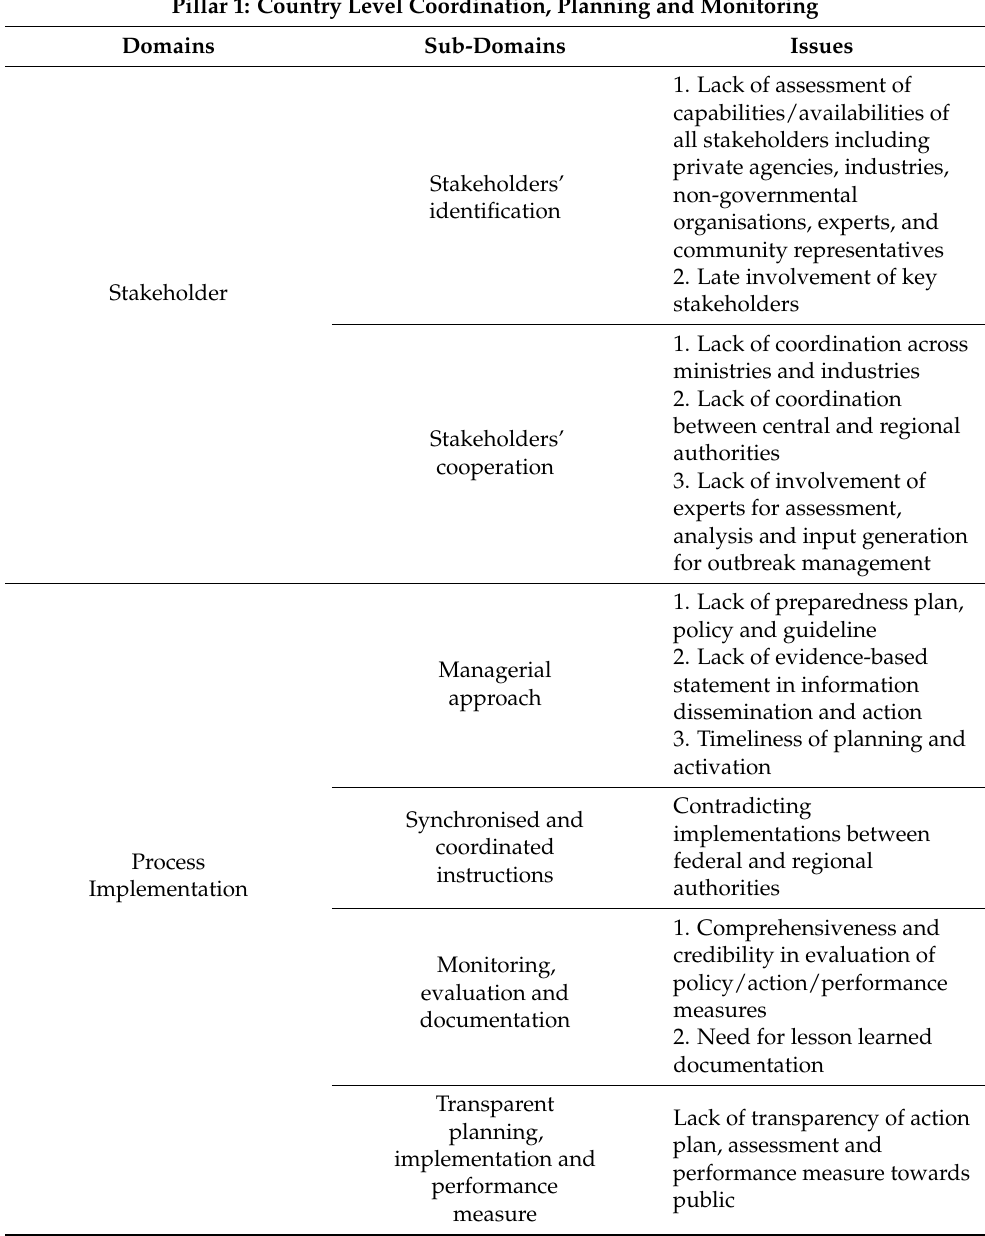
Table 2. Perception on health systems response at the early phase of